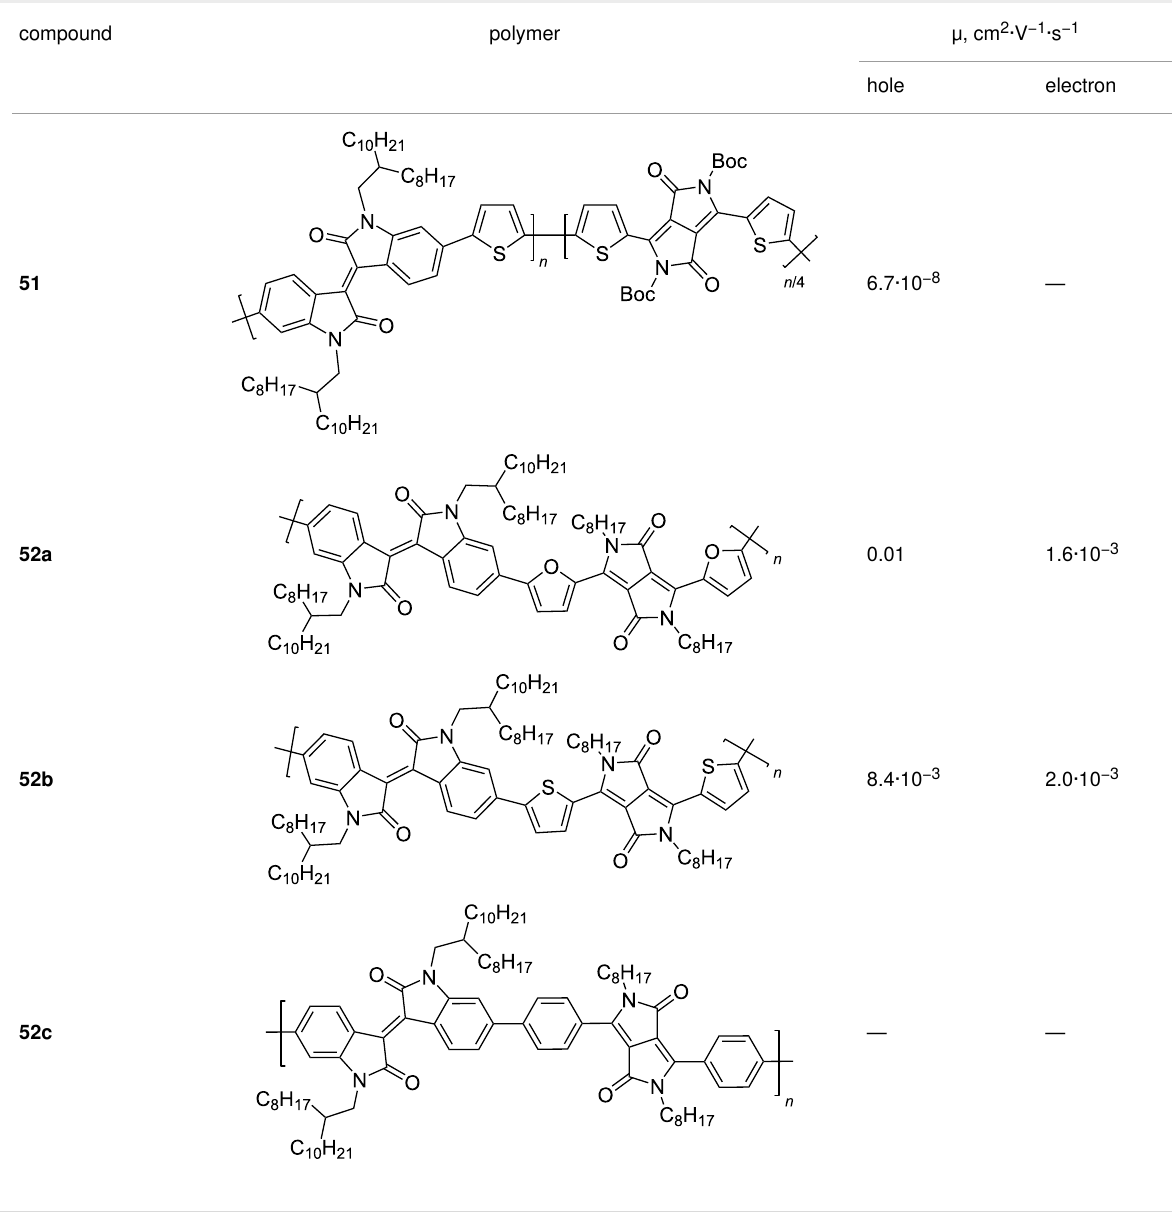
Table 7: Transistor characteristics of DPP–isoindigo-conjugated polymers 51 and 52 .